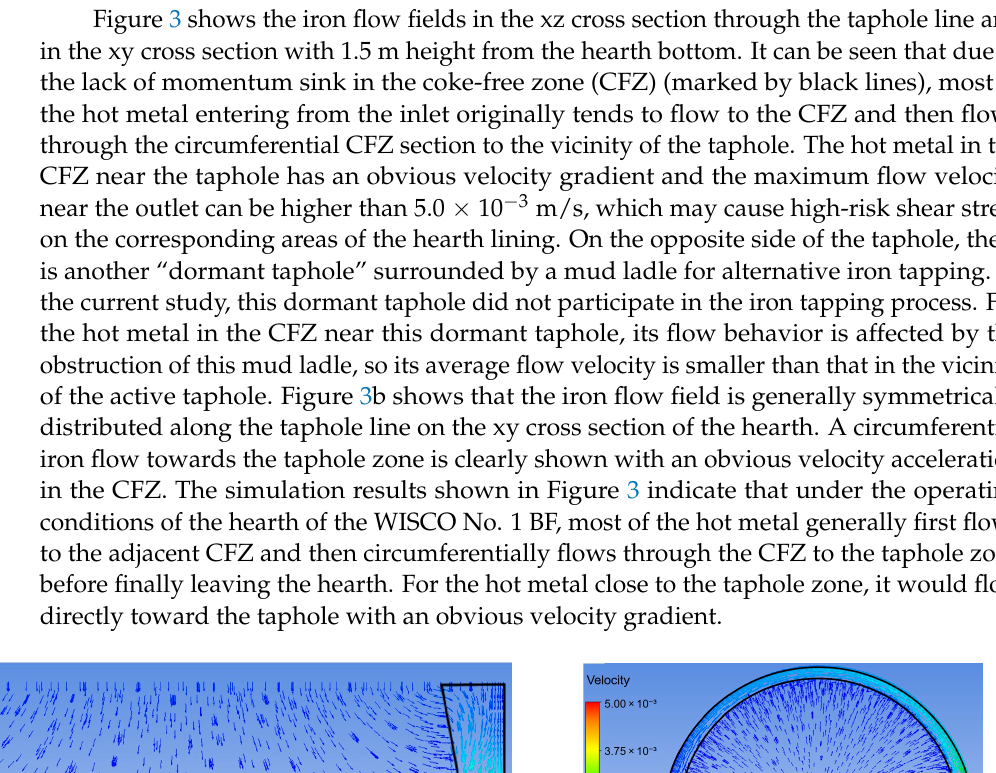
Figure 3 shows the iron flow fields in the xz cross section through the taphole line and